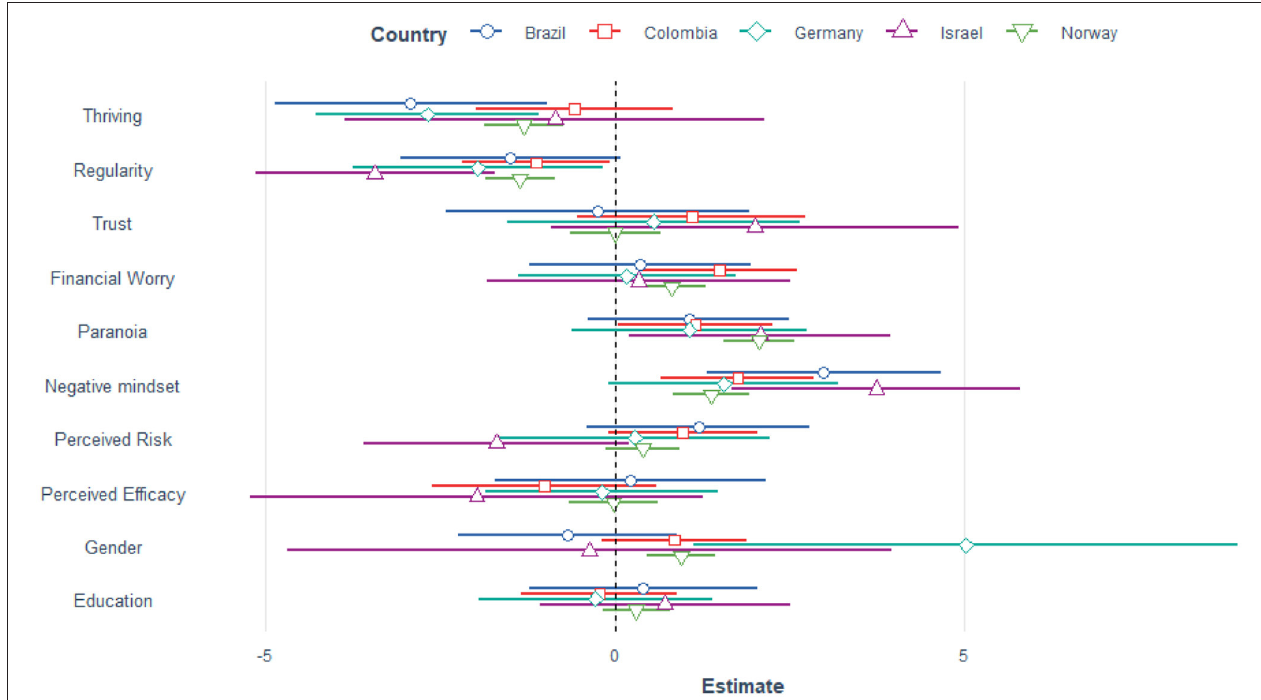
FIGURE 3 | Estimates for the 10 predictors of general distress per country, July data. As can be seen, the difference between the months and between the countries is smaller than between the predictors. Gender is coded as male = 0, 1 = female, 2 = other.